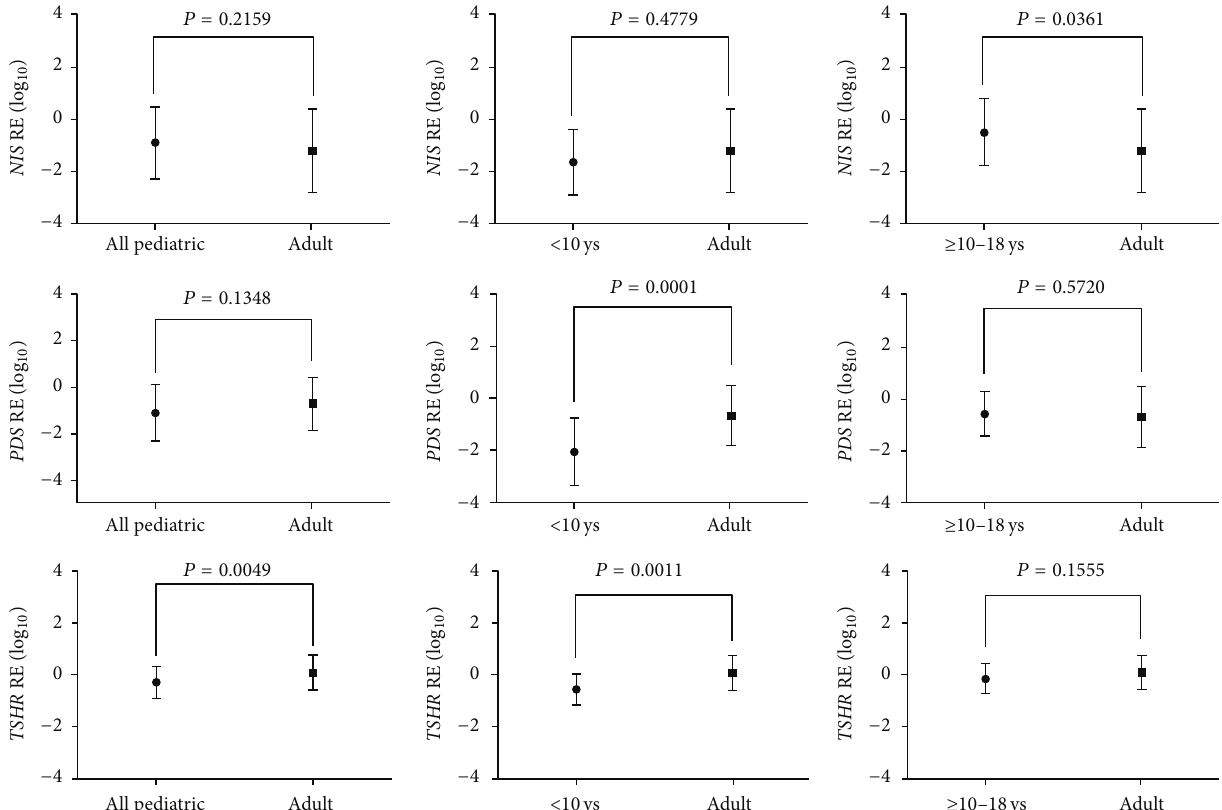
Figure 4: Relative expression (RE) of NIS , PDS , and TSHR in DTC patients stratified by age: all pediatric patients ( ≤ 18 years old; 𝑛 = 38 ), children ( < 10 years old; 𝑛 = 13 ), adolescents ( ≥ 10–18 years old; 𝑛 = 25 ), and adults ( ≥ 19 years old; 𝑛 = 115 ). The graphics shows the mean ( ± SD) expression level of log-transformed data. 𝑃 < 0.05 were considered statistically